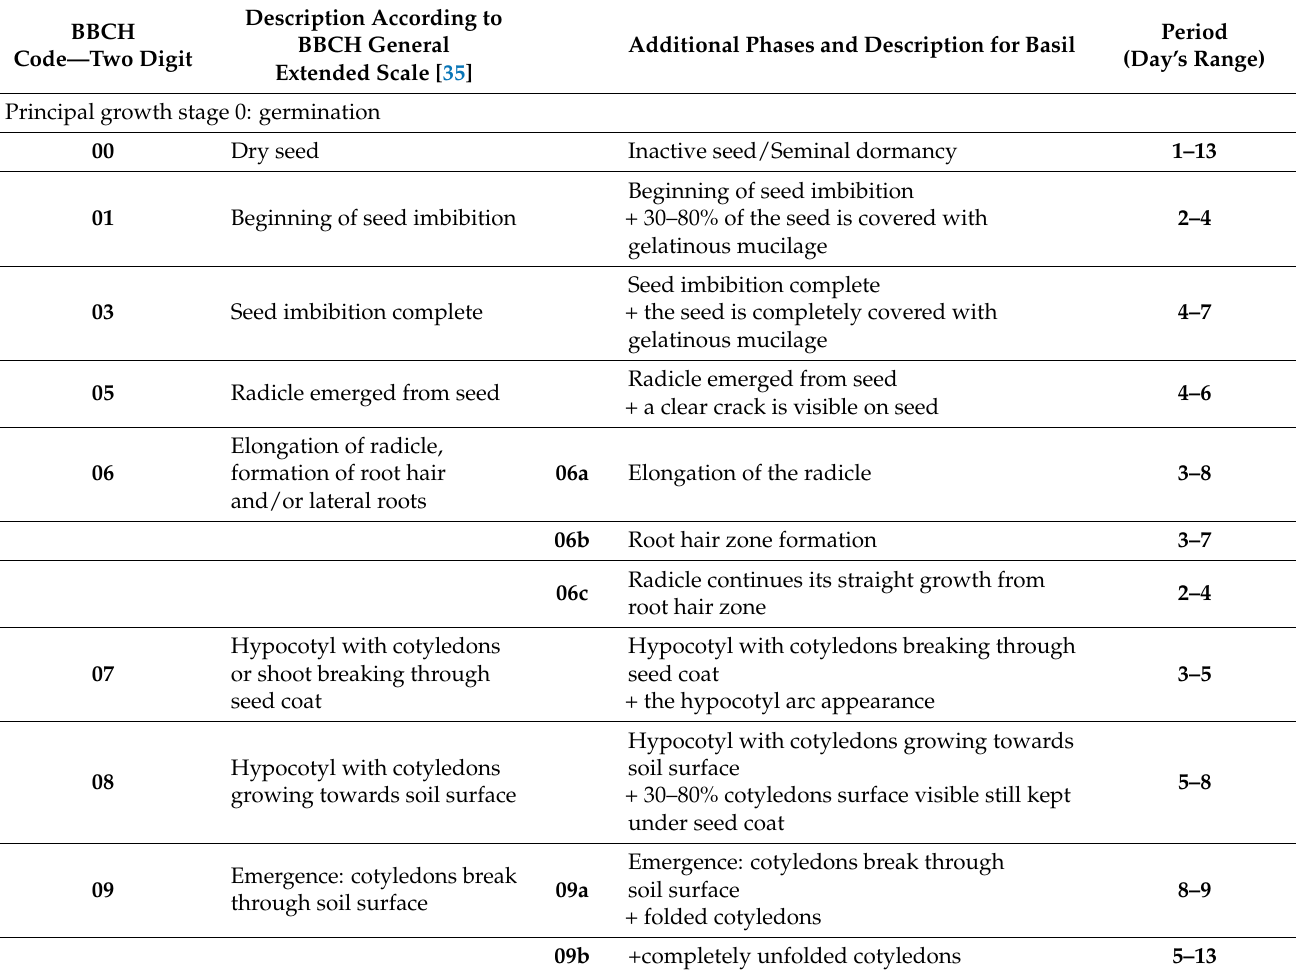
Table 2. Description of the phenological growth stages of basil ( Ocimum basilicum L.) according to the updated BBCH